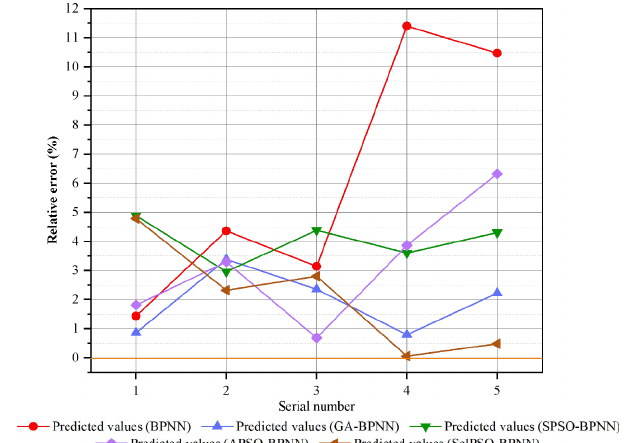
Figure 10. Comparison of coefficient of determination and mean squared error of different models.